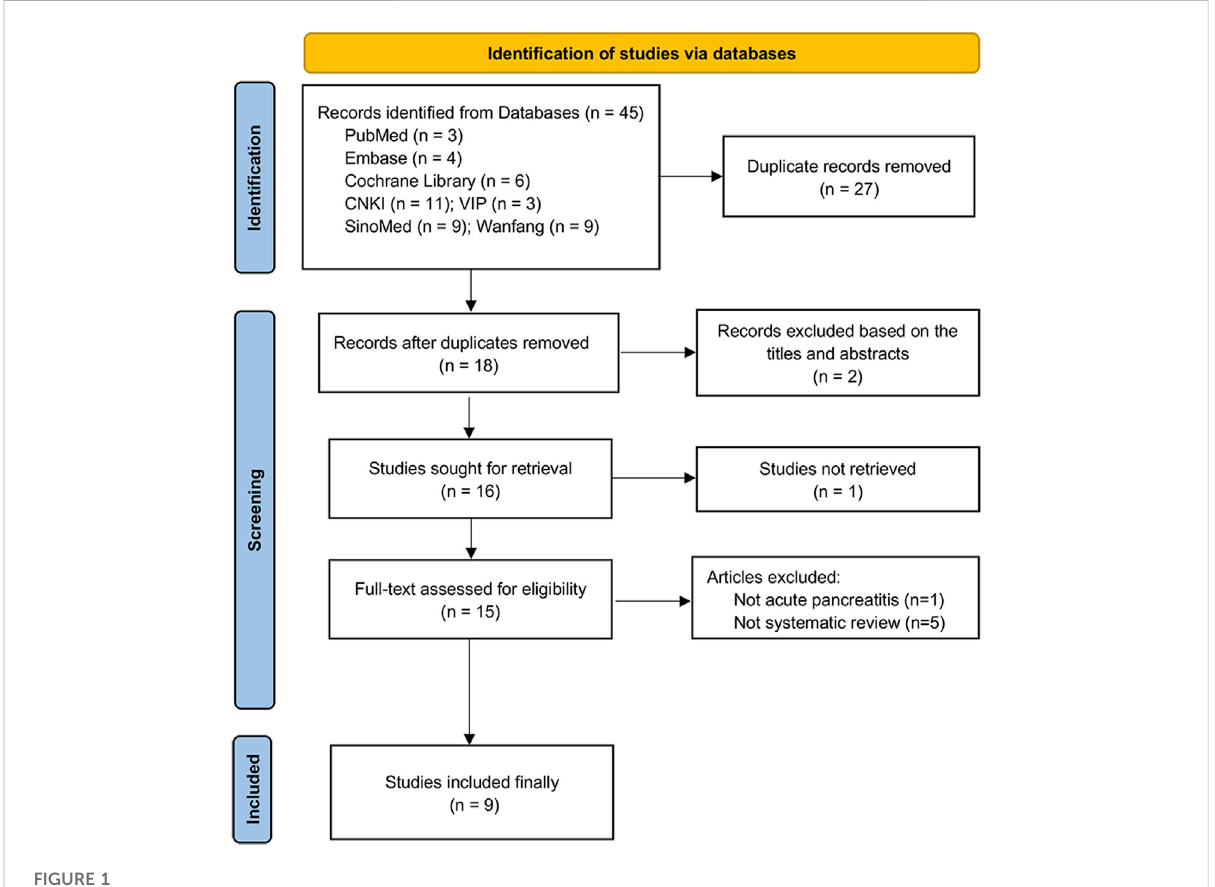
FIGURE 1 Flow chart of study